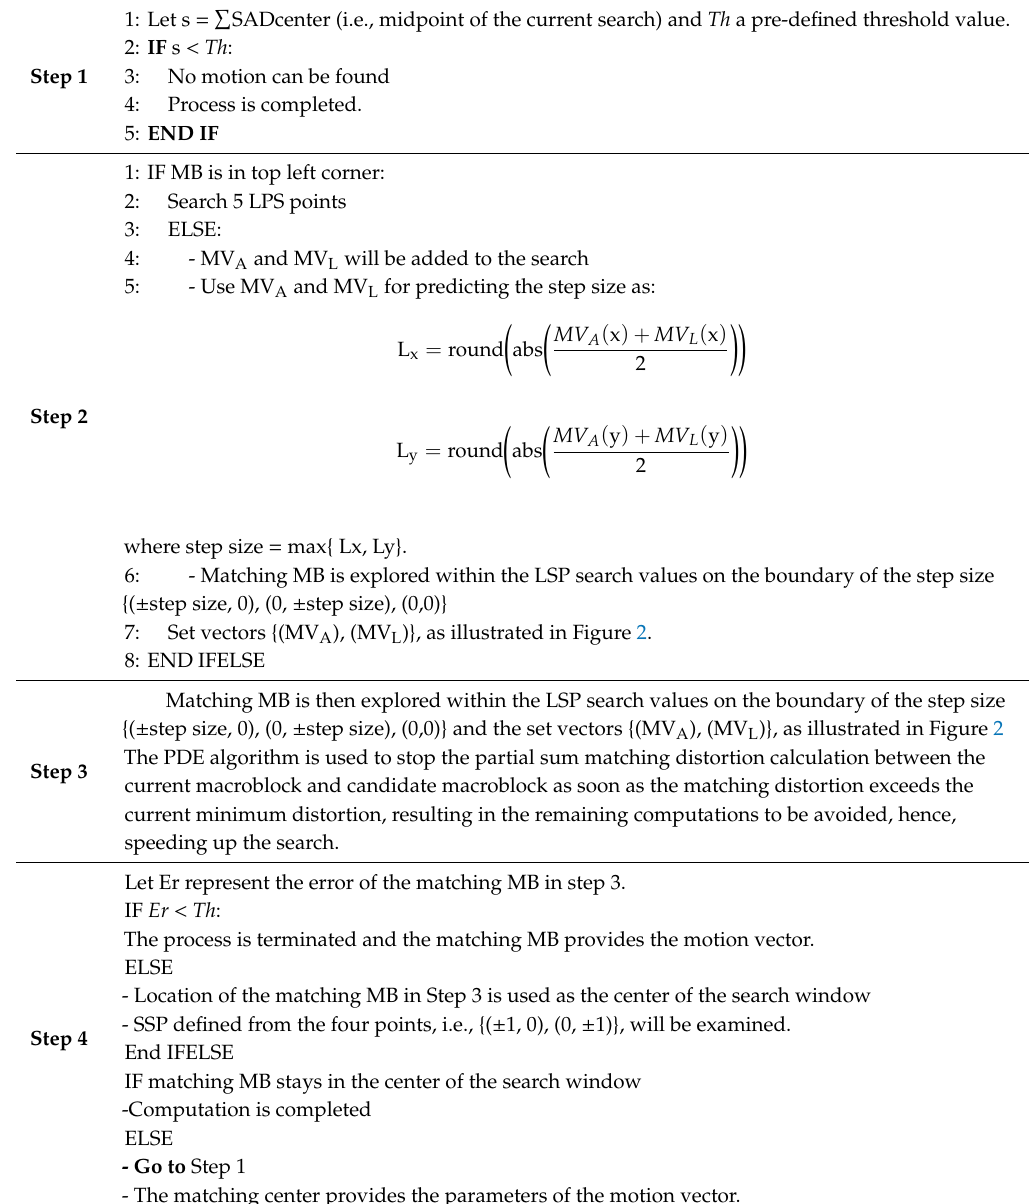
Algorithm 3 Proposed MPBM